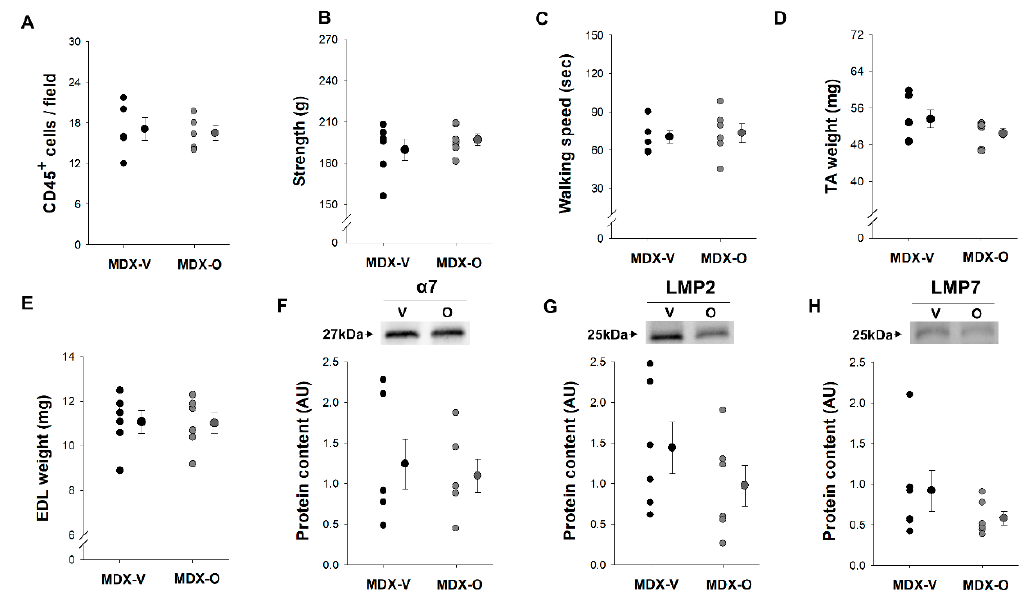
Figure 3. ONX-0914 treatment in MDX mice at seven weeks of age. The percentage of CD45 + cells in EDL muscles ( A ) of MDX mice treated with Vehicle (MDX-V, black filled circle) and treated with ONX-0914 (MDX-O, grey filled circle) were determined. Strength was determined by the grip meter test ( B ), walking speed was determined by the Rota-rod ( C ), and tibialis anterior muscle weight (TA, D ) and EDL weight (EDL, E ) in MDX-V and MDX-O mice were evaluated. The content of α 7 ( F , representative image), LMP2 ( G , representative image), and LMP7 ( H , representative image) was determined using Western blot analysis in the gastrocnemius muscles of MDX-V and MDX-O mice. Proteins were normalized to total protein (Supplemental Figure S1) and expressed as an arbitrary unit (AU). Data are presented as individual points (each mouse) with the mean and standard error of the means (S.E.M.). * indicates p < 0.05 comparing Vehicle to ONX-0914 treatment groups. Sample size: n = 5–6 in each group.